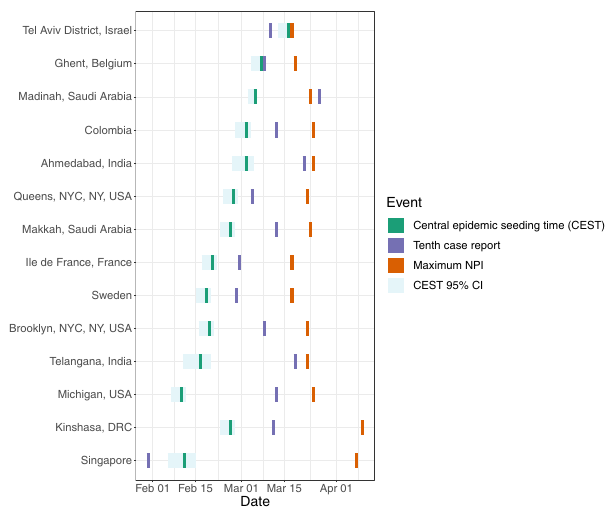
Fig. 3 Dates of central epidemic seeding time (CEST), tenth case report and maximum non-pharmaceutical interventions (NPI) for 14 of 57 sites included in our analysis. Sites are ordered by the duration of time between CEST and maximum NPI. Note that the CEST does not represent the earliest viral introduction but rather the mean time of viral introduction weighted by the number of samples descended from each viral introduction; thus it can be preceded by the tenth diagnosis if early diagnoses are not phylogenetically related to later infections (e.g., Singapore). CEST is shown with 95% con fi dence intervals (CI). 95% CI are rounded to the nearest day and therefore do not always look symmetrically distributed around CEST. We selected up to three sites from each world region for which sites were available (Europe, North America, Middle East, Asia, Africa) based on their having the highest death counts in the region. Supplementary Fig 3 shows these dates for all 57 sites.